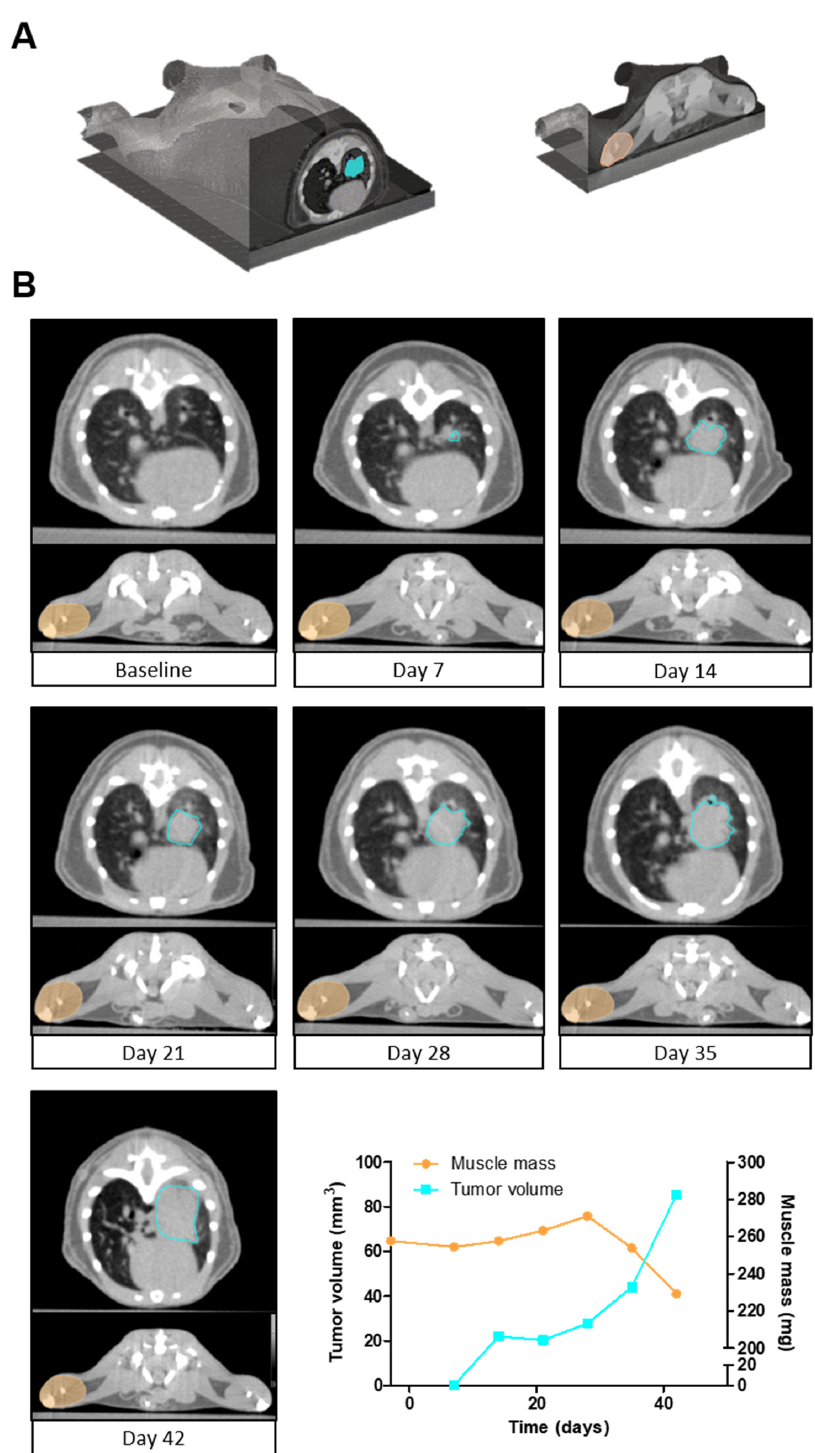
Figure 4. Longitudinal follow-up of tumor volume and muscle mass. ( A ) A 3D image of a whole- body mouse µCBCT scan indicating the region of the axial slices selected for ( B ). ( B ) A series of axial slices of µCBCT images illustrating the automatic lung tumor segmentations (light blue) and lower hind limb muscle complex segmentations (orange). The µCBCT images represent one mouse at seven different time points. The quantified tumor volumes (light blue) and muscle masses (orange) are presented over time in the line